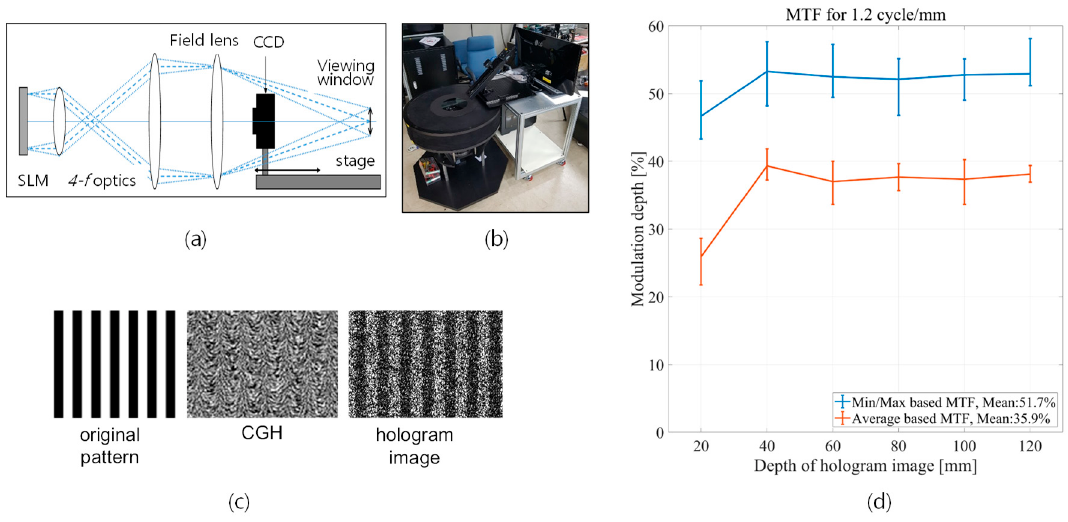
Figure 11. 3D-MTF measurement: ( a ) design of test method, ( b ) environment setup for measurement, ( c ) test pattern, and ( d ) result of the measurement.